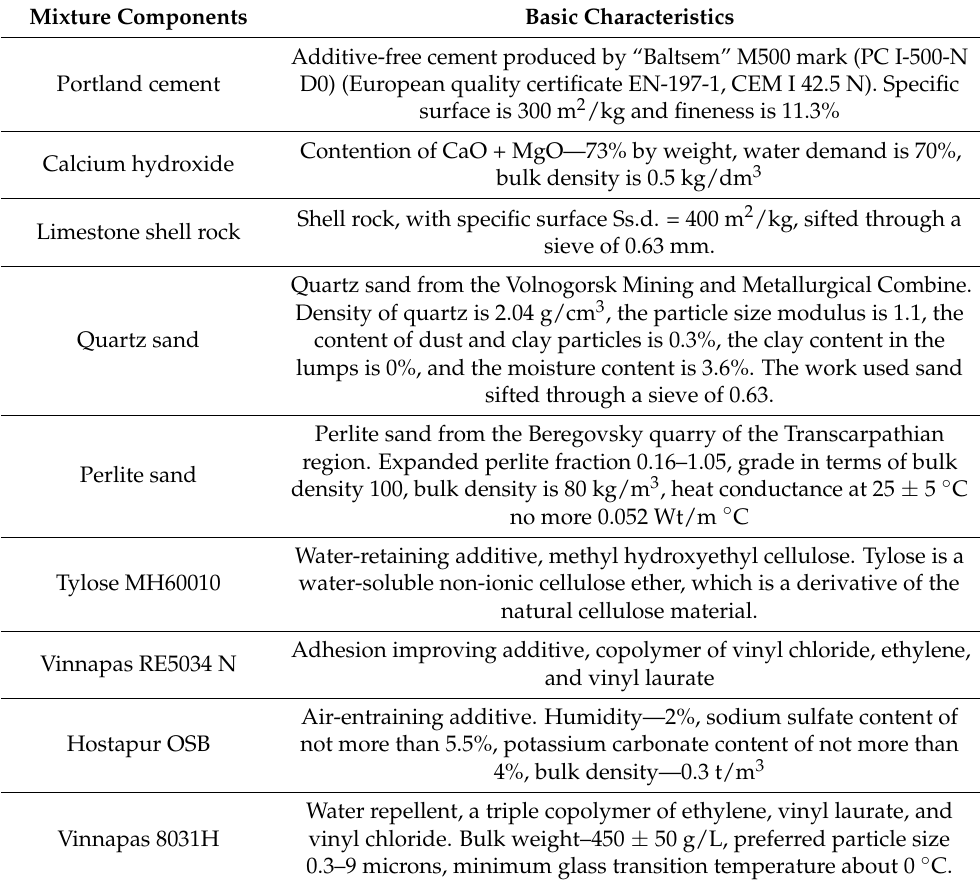
Table 1. Basic characteristics of used mixture components. Mixture